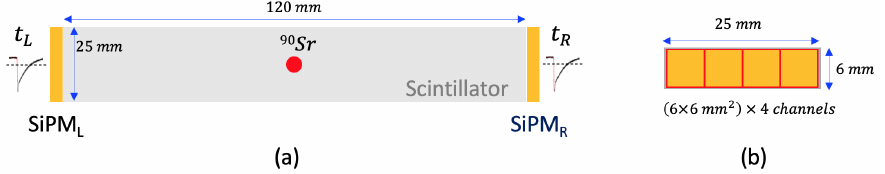
opposite sides. ( a ) Top view: A radioactive source, 90 Sr, is placed at the middle of scintillator. The scintillation light is collected at both SiPMs. ( b ) Side view: Each side of the scintillator is fully faced with four SiPM